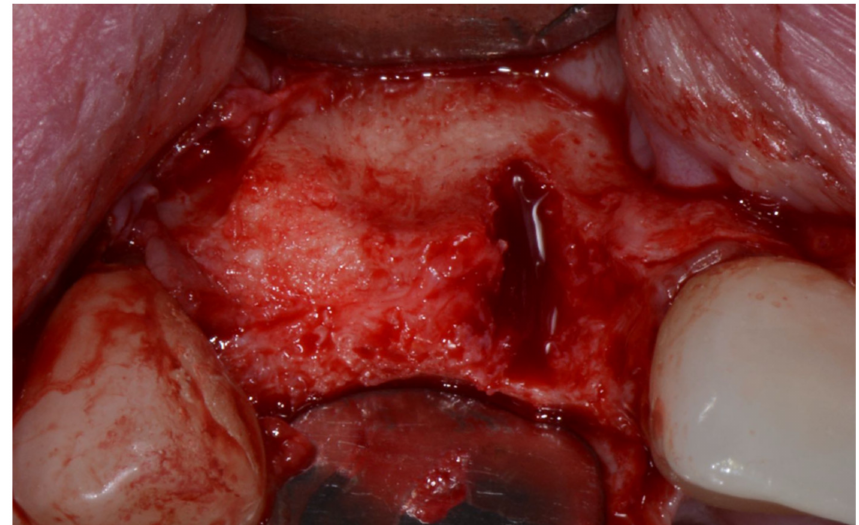
Figure 13. The edentulous area showed some healing at the site of 12 but still a deep dehiscence on